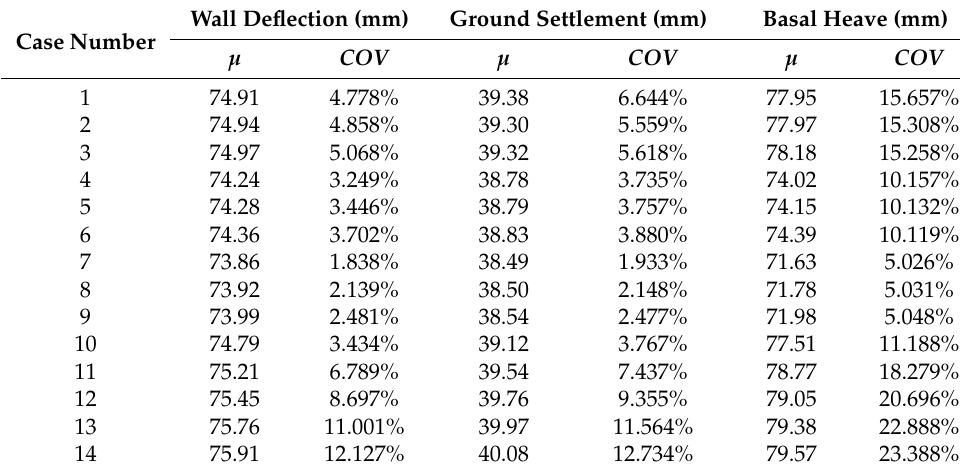
Table A1. Statistical character of responses of